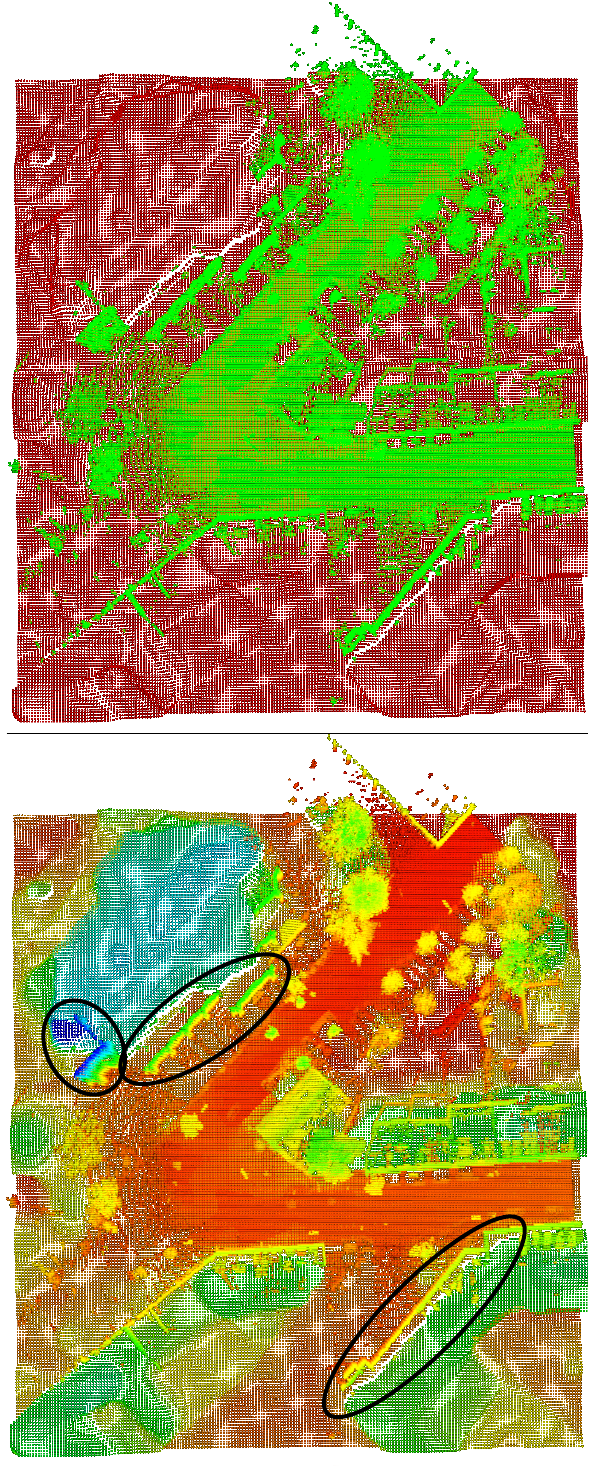
Figure 8. Result of fusion with standard ICP without surface smoothing. Top: Monochrome colors (green: LiDAR point cloud, red: landscape model derived from satellite images). Bot- tom: Same view with colors encoding point heights. Notice the height discrepancy at the boundary between facades, which are visible only in the LiDAR-based point cloud (appearing as dense lines), and the rooftops which are visible only in the satellite im- ages (appearing as points arranged in a grid